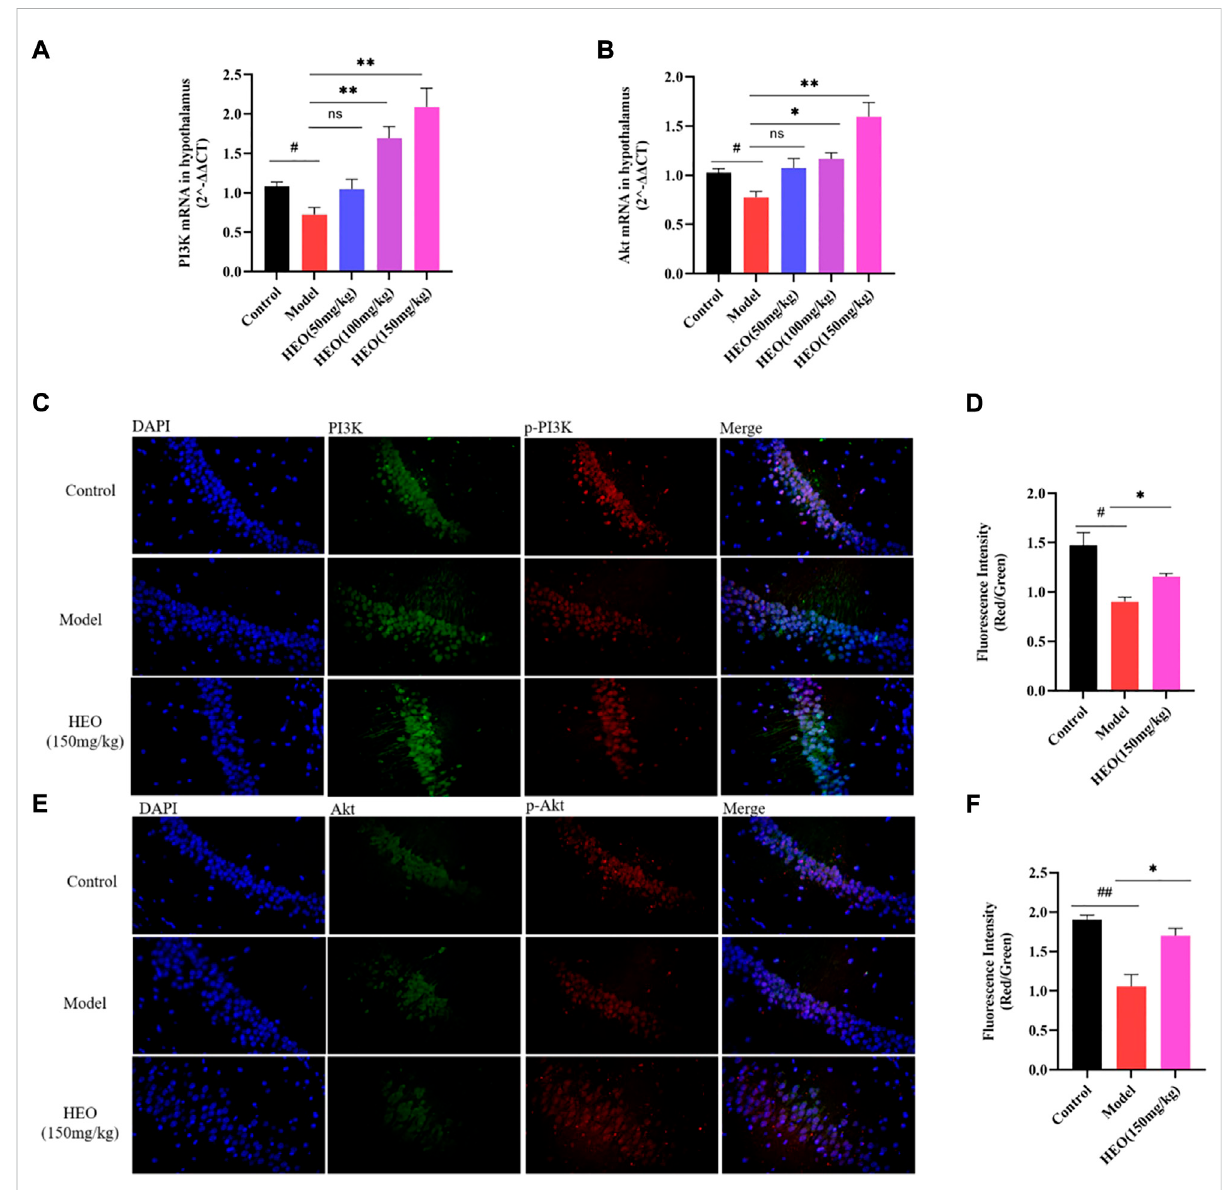
FIGURE 8 Effects of HEO on mRNA expressions of PI3K (A) and Akt (B) , and protein expression of PI3K/p-PI3K, Akt/p-Akt in hippocampus. Immuno fl uorescence images of PI3K (green), p-PI3K (red), and DAPI (blue) (C) ; immuno fl uorescence images of Akt (green), p-Akt (red), and DAPI (blue), Merged images were shown in the right panel (400×) (E) ; Quanti fi cation analysis of (D) and (F) . Data were expressed as mean ± SEM ( n = 3). # p < 0.05, ## p < 0.01 vs control group; * p < 0.05 vs the CUMS